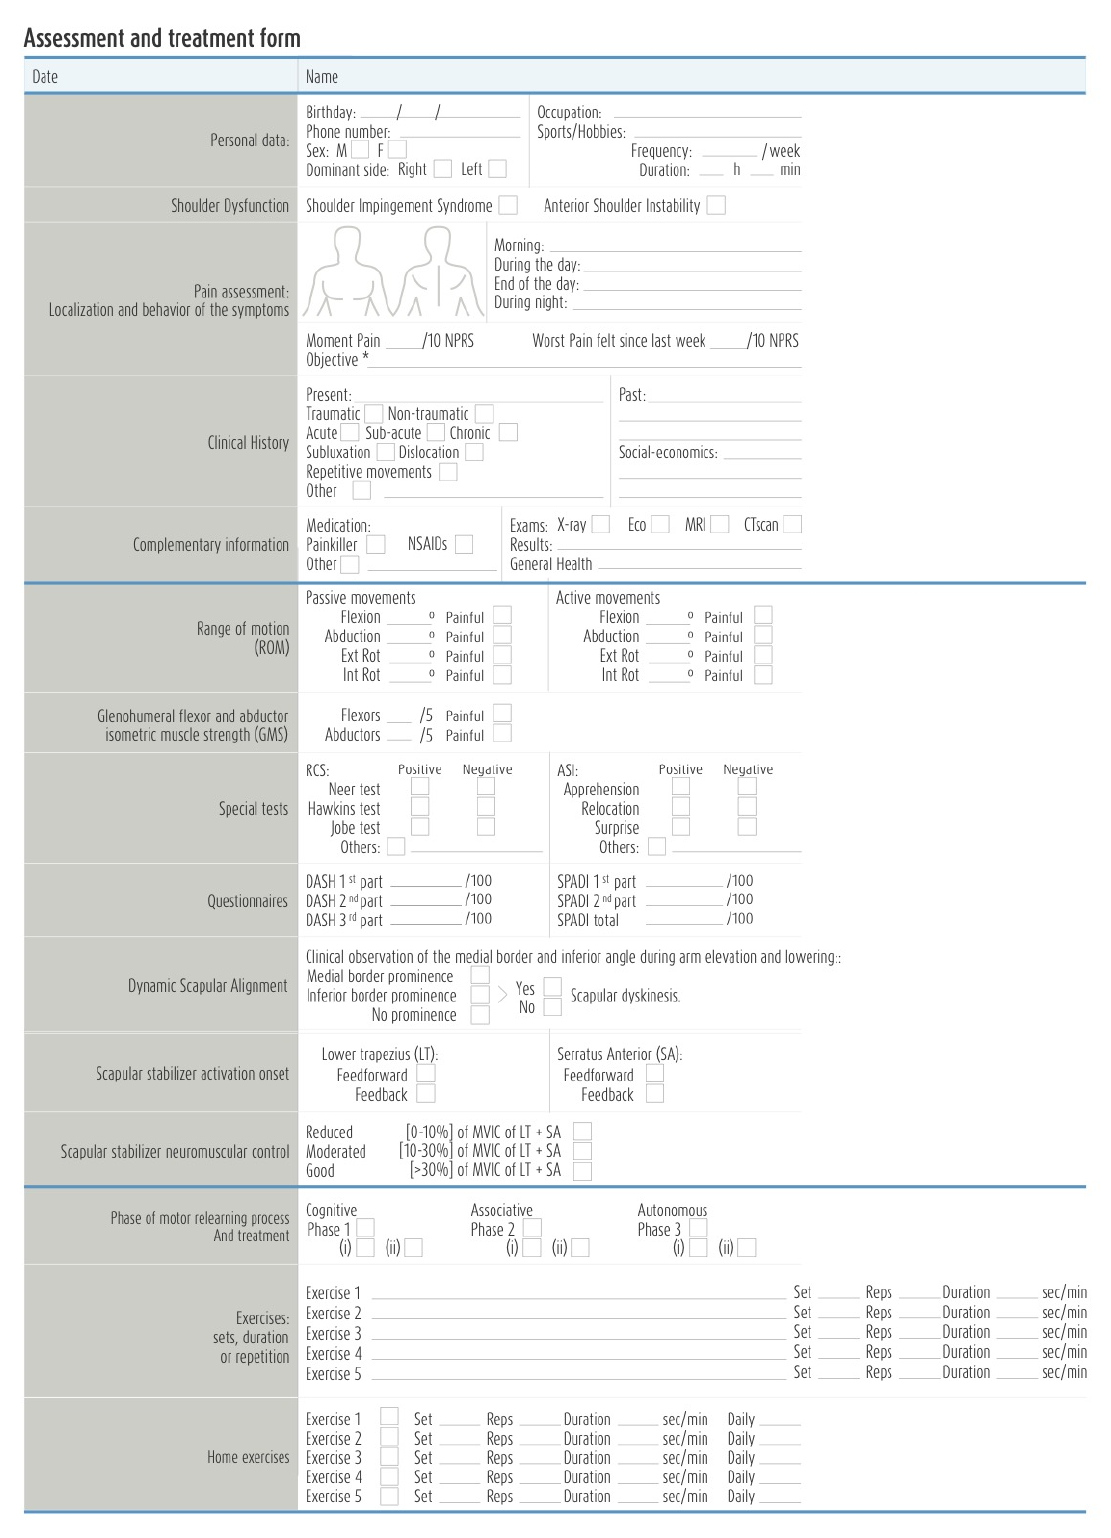
Figure A1. Assessment and treatment form.